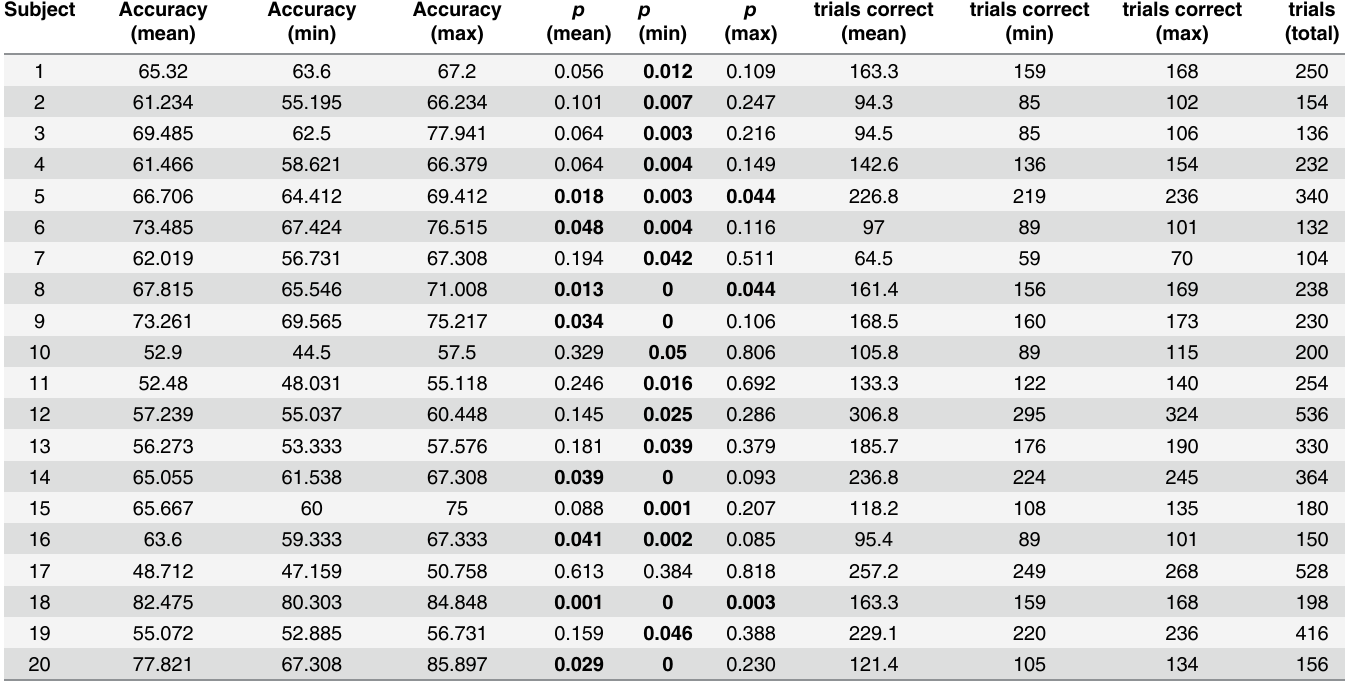
Table 9. Results Across Task Pe: Train Flanker, Classify